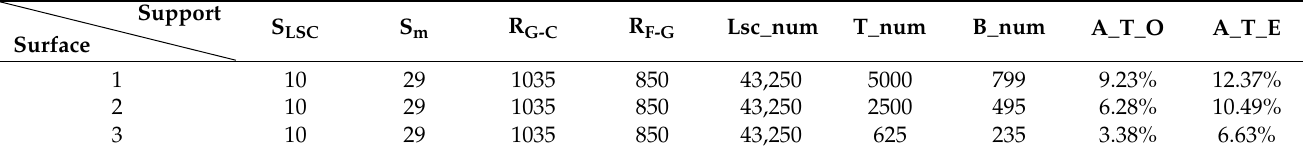
Table 1. Results for relevant parameters of variable-scale